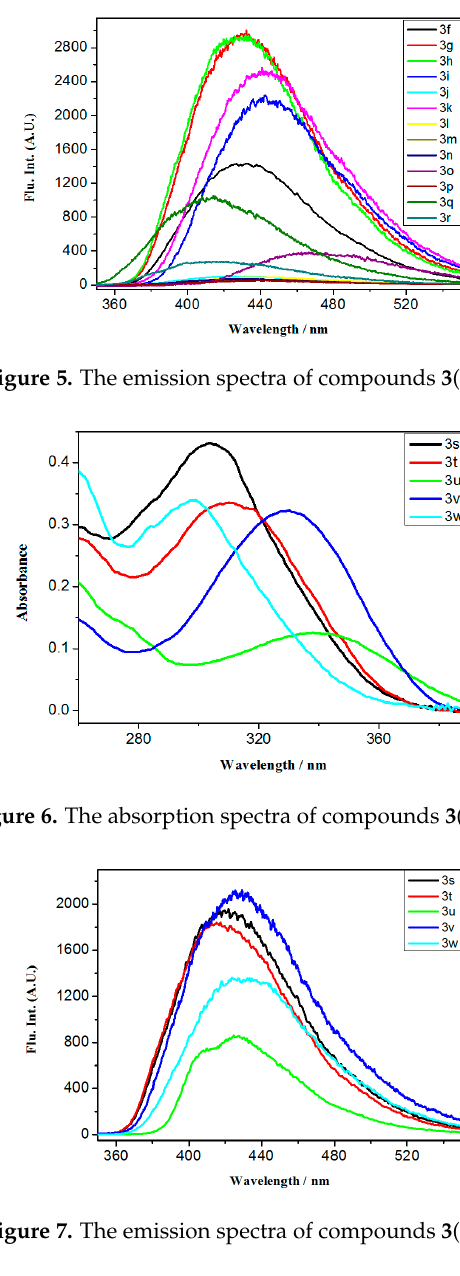
Figure 4. The absorption spectra of compounds 3 ( f – r ).